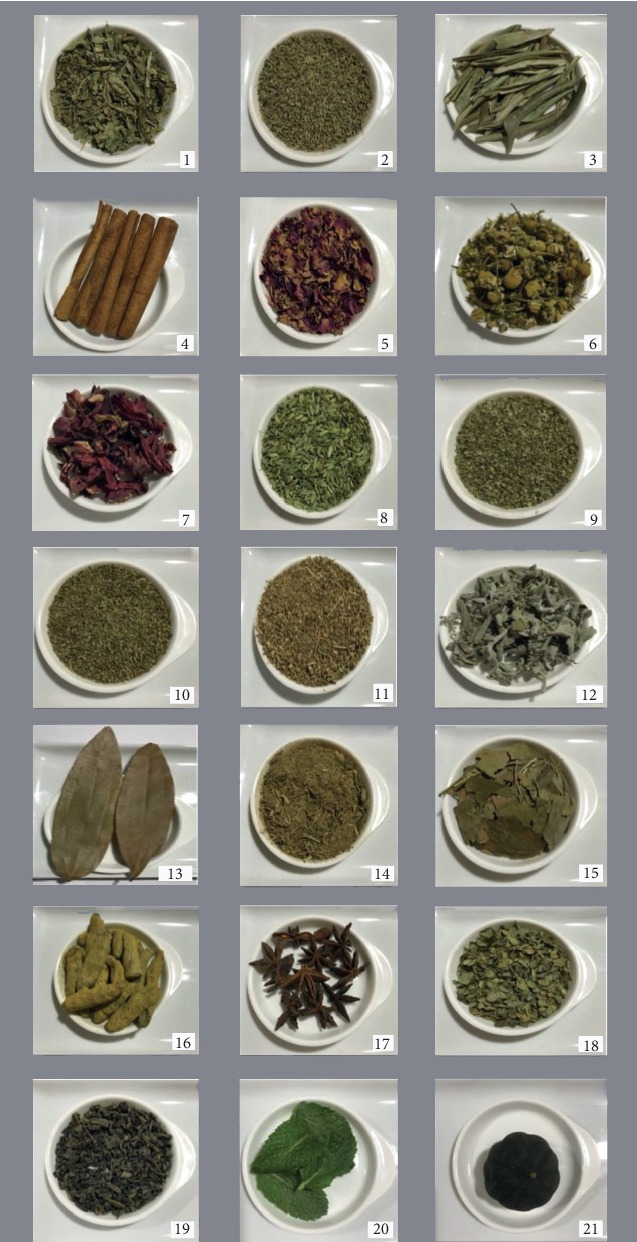
Images of herbal plants acquired and analyzed, which correspond to plants in Table 1.